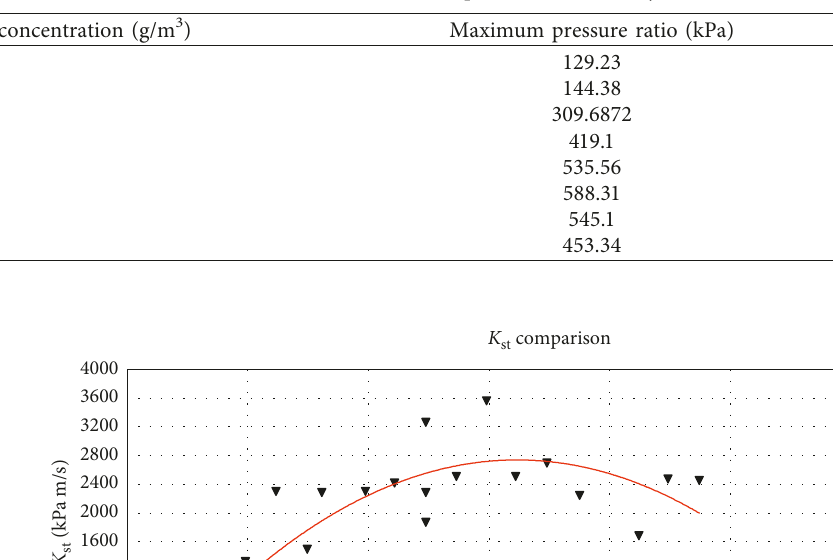
Table 3: Explosion criteria analysis.